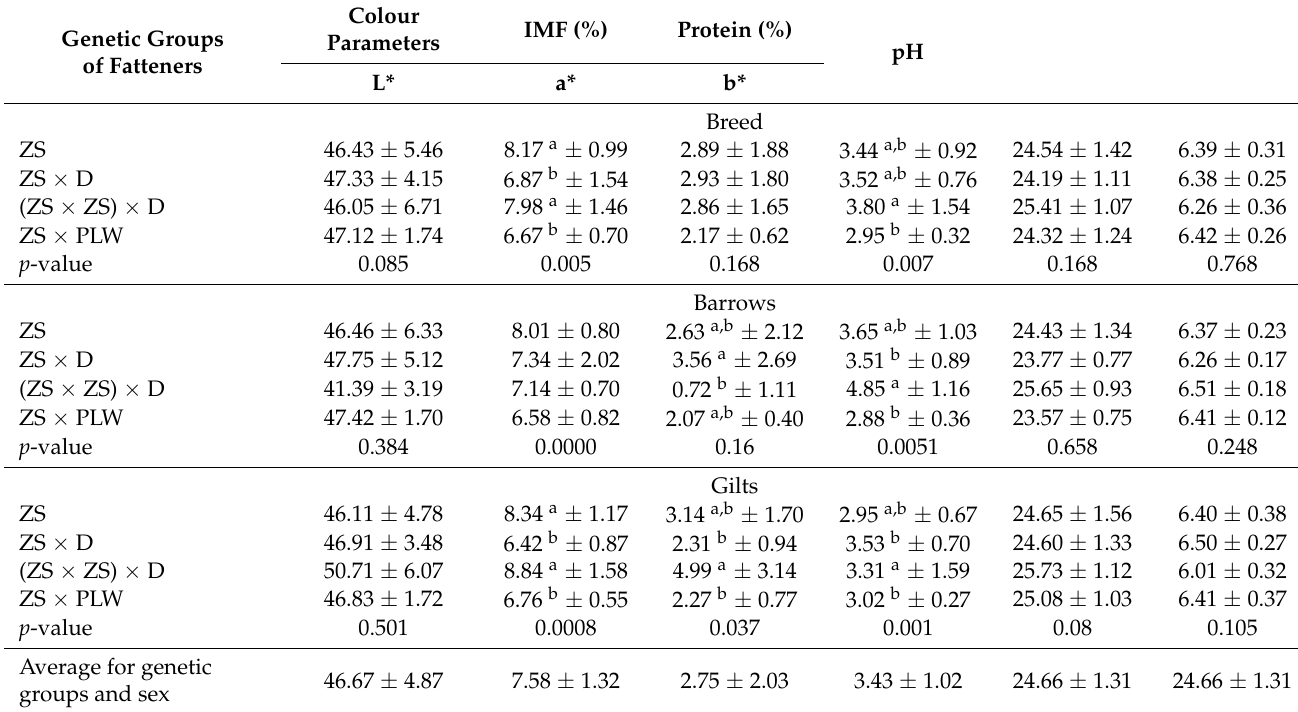
Table 4. Quality characteristics of raw meat m. longissimus thoracis .